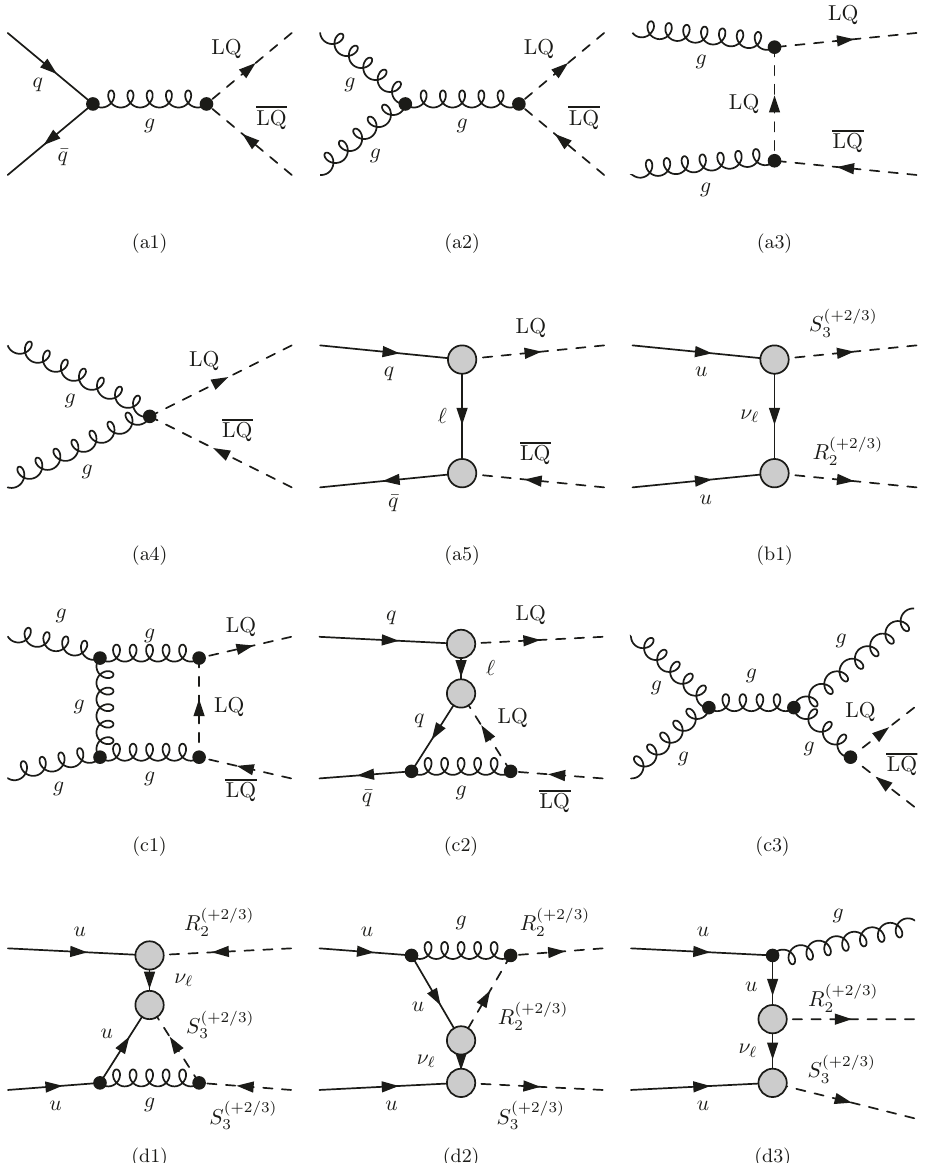
Figure 1 . Selection of Feynman diagrams contributing to scalar leptoquark pair production in hadron collisions, both for the diagonal and off-diagonal channel (for which we have chosen the pp → R (+2 / 3) S (+2 / 3) example). QCD couplings are indicated by a black point, while a grey circle 2 3 denotes the lepton-quark-leptoquark Yukawa couplings. Born diagrams are shown in the sub-panels (a1)–(a5) for the diagonal case, and (b1) for the off-diagonal one. Virtual correction and real emission diagrams are shown in sub-panels (c1)–(c3) and (d1)–(d3)